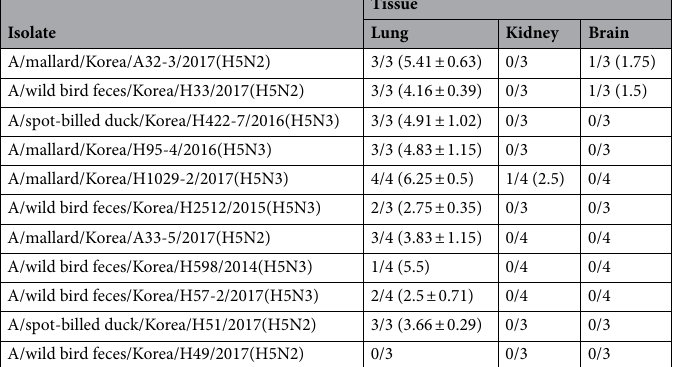
Table 4. Virus titers in tissues from 6-week-old female BALB/c mice challenged with representative H5 isolates. Values shown are number of mice with virus in the tissue/number of inoculated mice. Values in parentheses are virus titers (log 10 EID 50 /g). For multiple infected tissues, the virus titer is the mean ± standard deviation of the samples. EID 50 , 50% egg-infective